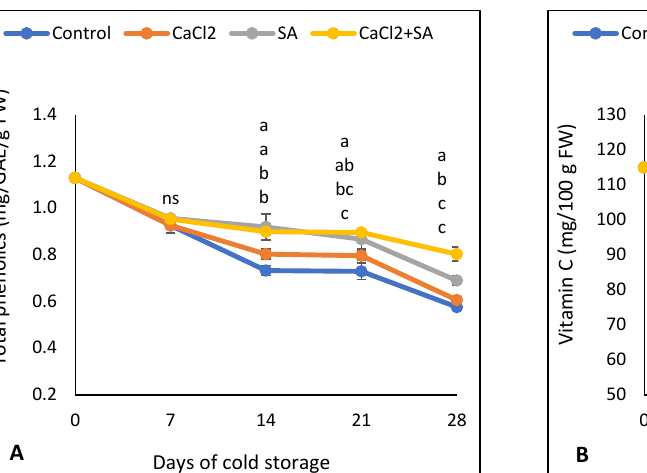
Table 1. Pearson ’ s correlation among the evaluated parameters of broccoli florets.